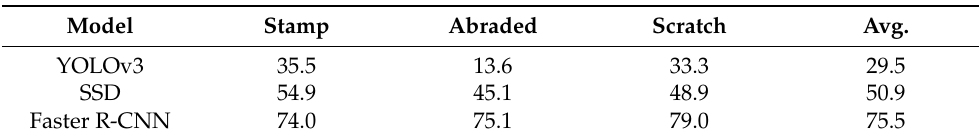
Table 4. Performance comparison of different learning-based defect detection methods on our PSDD dataset. Numbers represent mAP (%).